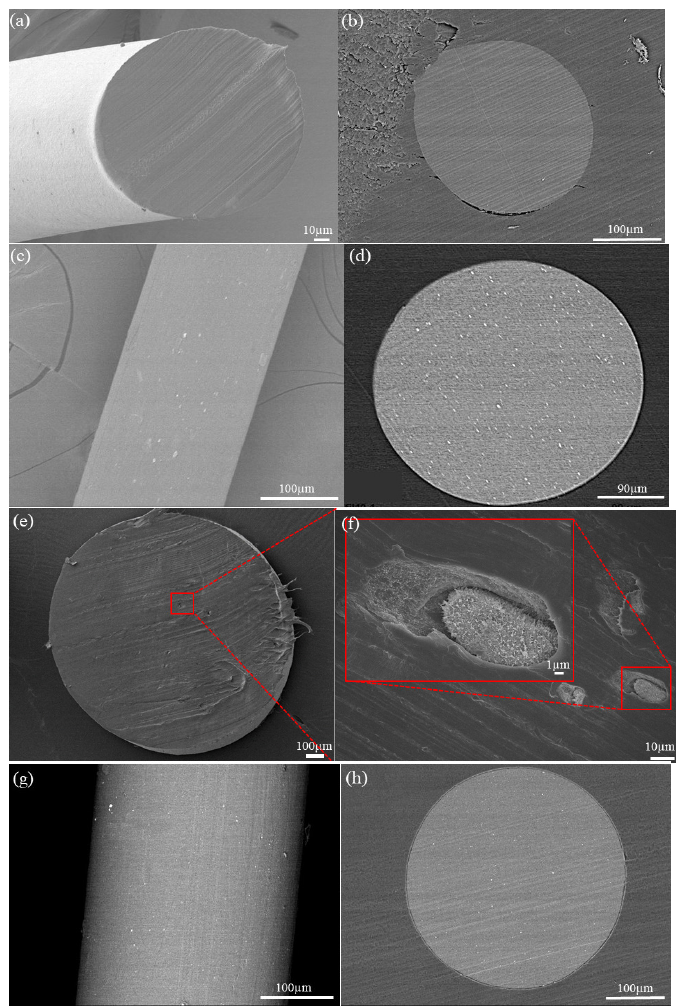
Figure 2. SEM images of the nanocomposite fibers:( a ) surface and ( b ) cross section of PVDF fiber; ( c ) surface and ( d ) cross section of PVDF/BT (10 wt%); ( e , f ) low and higher magnification of cross- section of PVDF/rGO fiber (0.5 wt%) with the low content of graphene nanosheets with the dimen- sion of 200–400 nm; and ( g , h ) surface and cross section of PVDF/rGO/BT fiber.